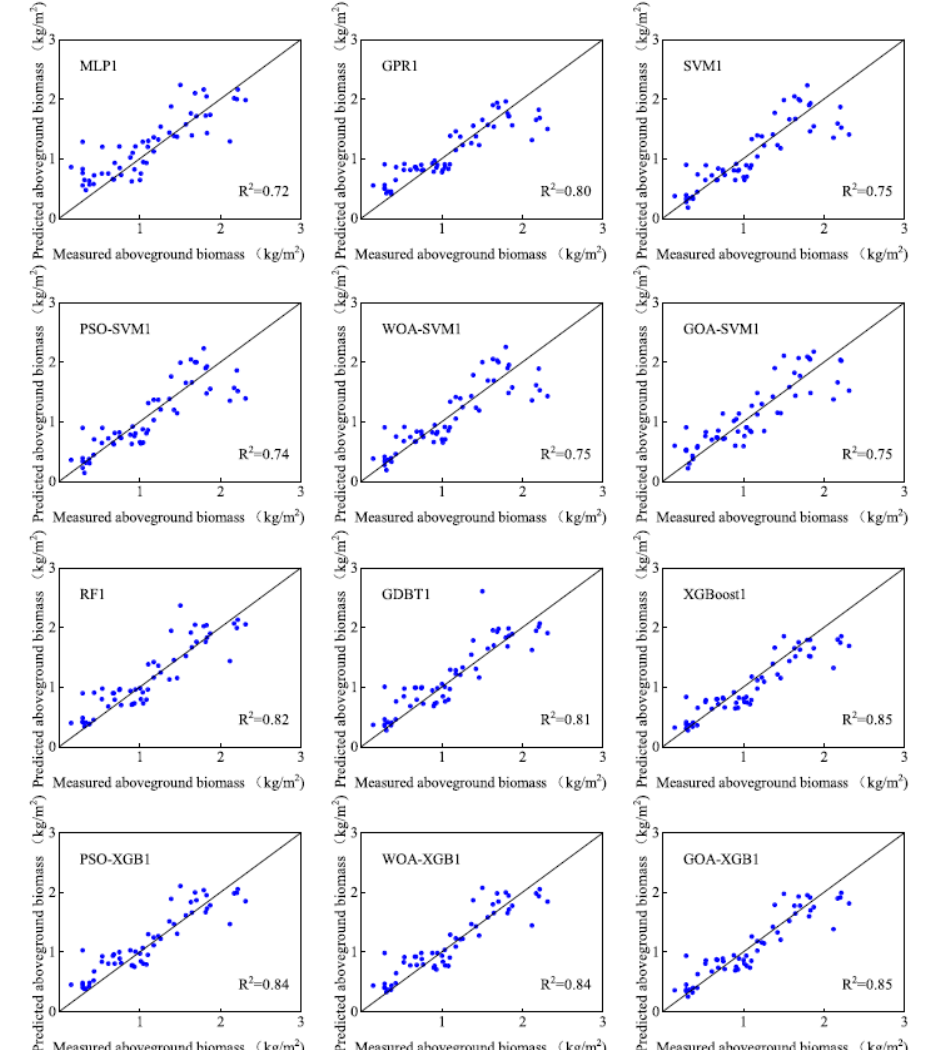
Figure 4. Scatter plot of AGB estimated by eight machine learning models vs. measured AGB.